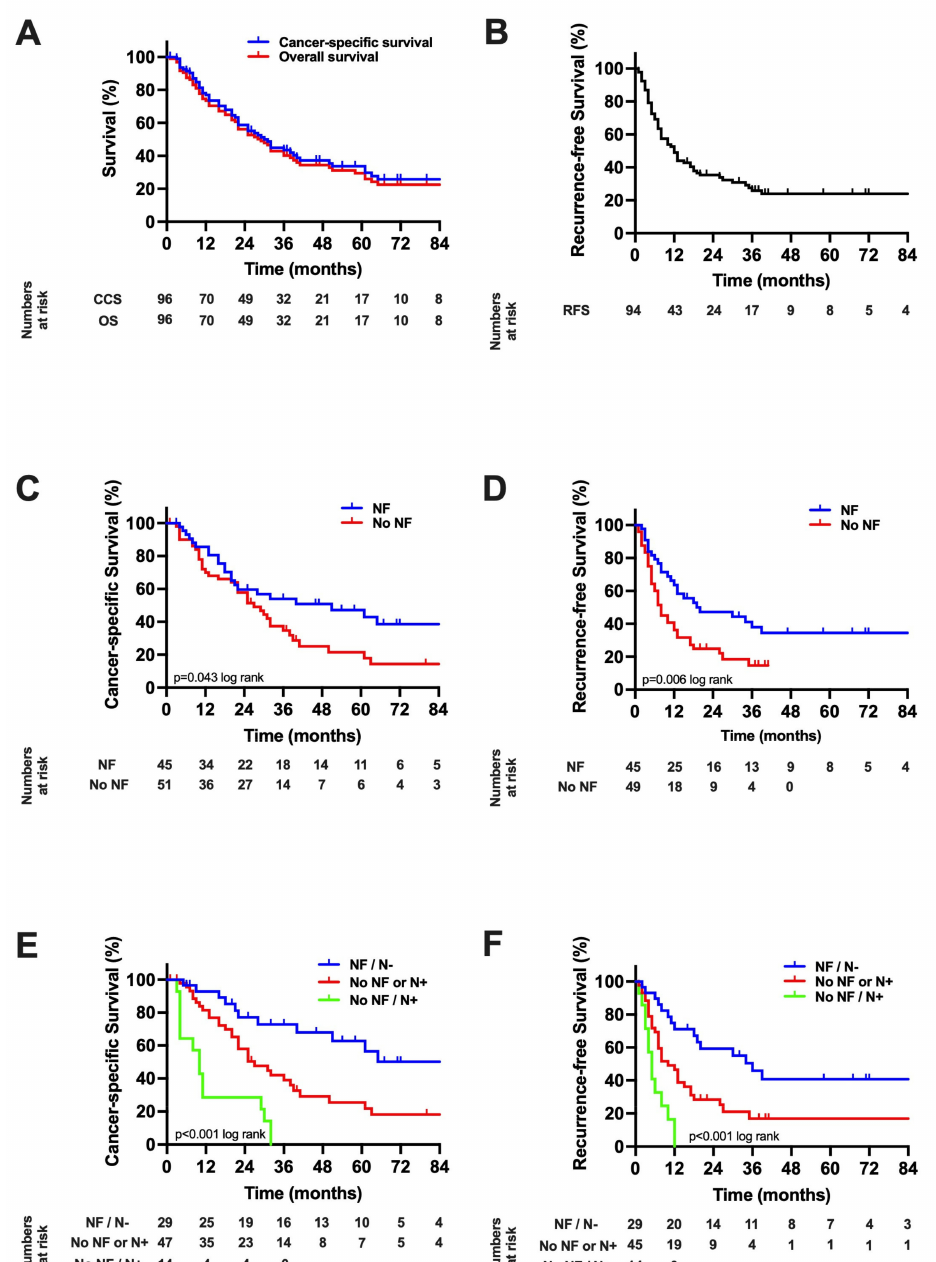
Figure 3. Oncological survival in intrahepatic cholangiocarcinoma ( A ): Cancer-specific and overall survival. The median CSS was 30 months and the median OS 28 months, respectively. ( B ): Recurrence-free survival. The median RFS was 12 months. ( C ): Cancer-specific survival stratified by nerve fibers. The median CSS was 51 months in patients with NF compared to 27 months ( p = 0.043 log rank). ( D ): Recurrence-free survival stratified by nerve fibers. The median RFS was 20 months in patients with NF compared to 8 months in patients without NF ( p = 0.006 log rank). ( E ): Cancer-specific survival stratified by nerve fibers and pN category. The mean CSS was 89 months in patients with NF and negative lymph nodes, while the median CCS was 27 months (95% CI: 38–64) in patients with either positive lymph nodes or without NF but not both, and 10 months in patients with both positive lymph nodes and low NF ( p = 0.001 log rank). ( F ): Recurrence-free survival stratified by nerve fibers and pN category. The median RFS was 36 months in patients with NF and negative lymph nodes, 10 months (95% CI: 8–82) in patients with either positive lymph nodes or no NF but not both, and 5 months in patients with both positive lymph nodes and no NF ( p = 0.001 log rank). CI, confidence interval; CSS, cancer-specific survival; RFS, recurrence-free survival; OS, overall